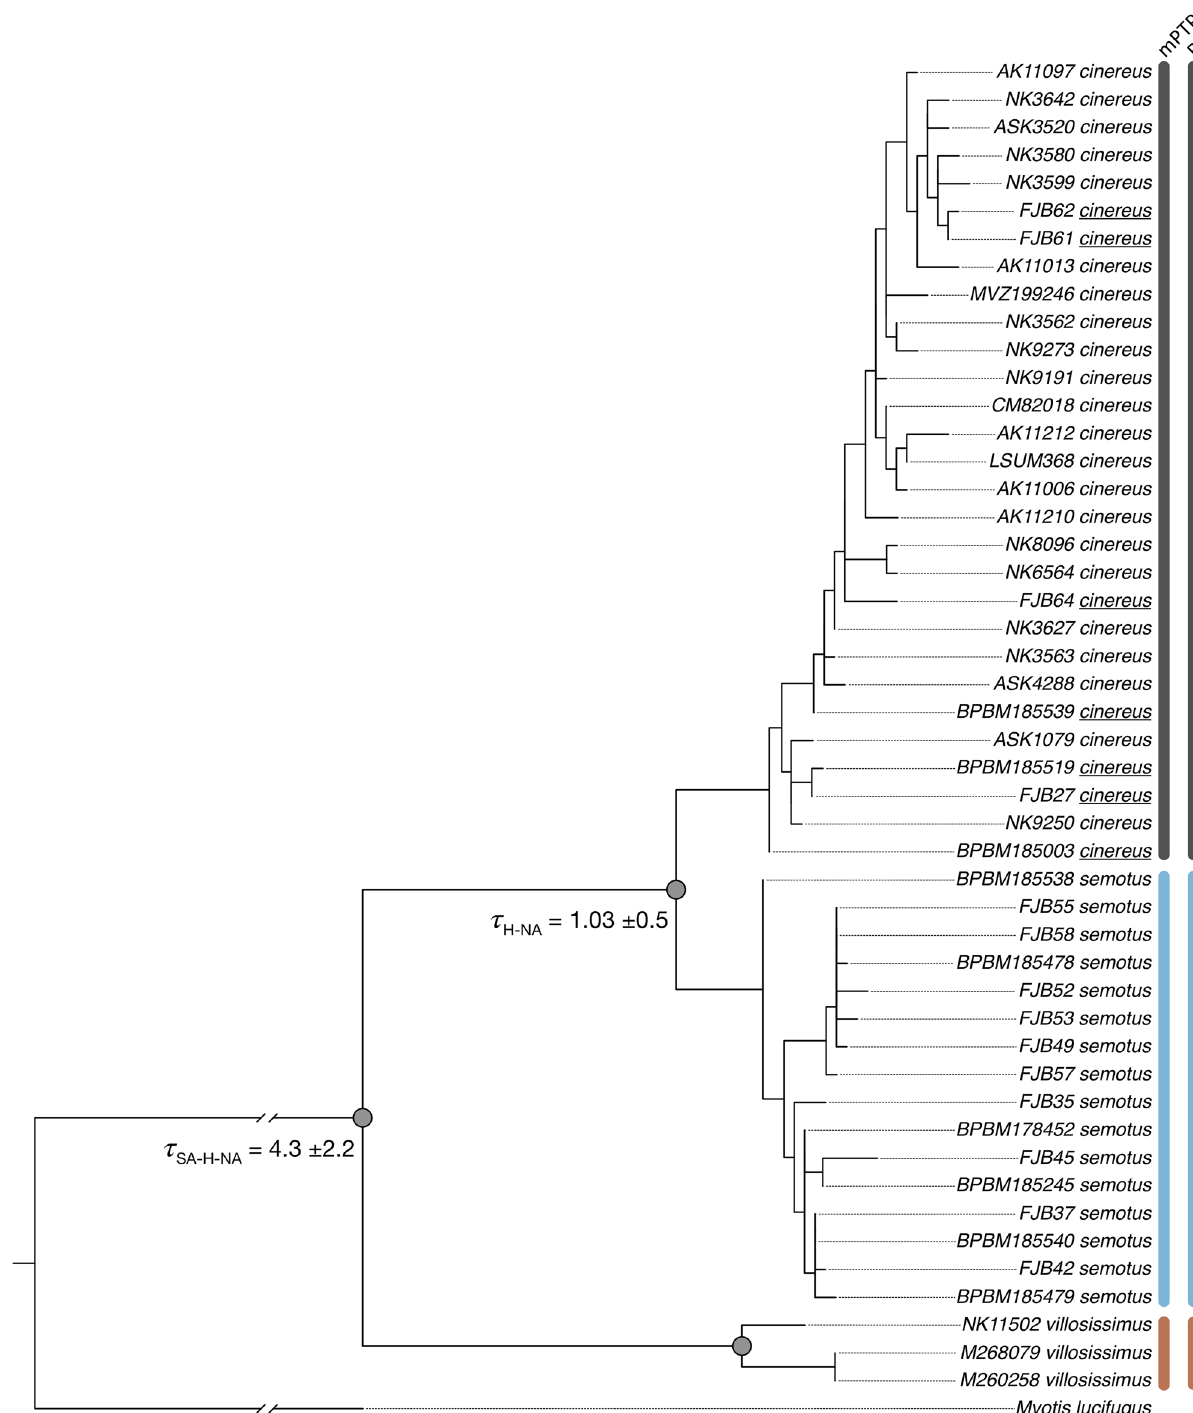
Figure 1. Phylogenetic relationships of Hoary bats (genus Lasiurus ) based on mitochondrial COI and nuclear RAG2 sequences. Maximum Likelihood (shown) and Bayesian (Fig. S1) analyses recovered identical topologies. Colored circles at nodes represent maximum likelihood Transfer Bootstrap Expectation (TBE) > 70% and Bayesian Posterior Probability (PP) > 0.99 estimated in RaxML-NG and MrBayes, respectively. Divergence times (τ) and 95% HPD were estimated using Bayesian Phylogenetics and Phylogeography (BPP) and shown at species level nodes. Each vertical bar on the right corresponds to summarized results of multi-rate Poisson Tree Process (mPTP) and BPP species delimitation analyses based on the same topology hypothesis and alignment, respectively. Both mPTP and BPP results agree that Hoary bats constitute three species. Terminal taxa represent species names with their respective collection and specimen numbers. Names of specimens of L. cinereus resident of Hawaii are underlined. Myotis lucifugus (GenBank MG423465.1) was used as